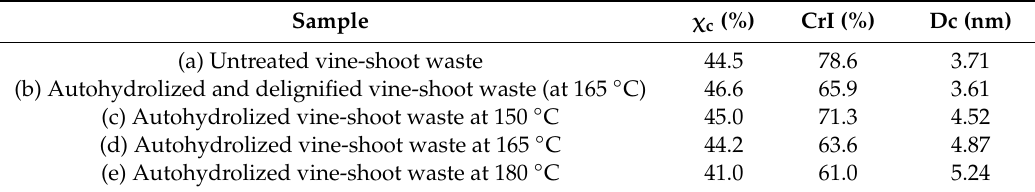
Table 3. The degree of crystallinity ( χ c ), the crystallinity index (CrI) and crystallite size (D C ) calculated from XRD data of untreated, delignified vine-shoot waste and pretreated at 150, 165 and 180 ◦